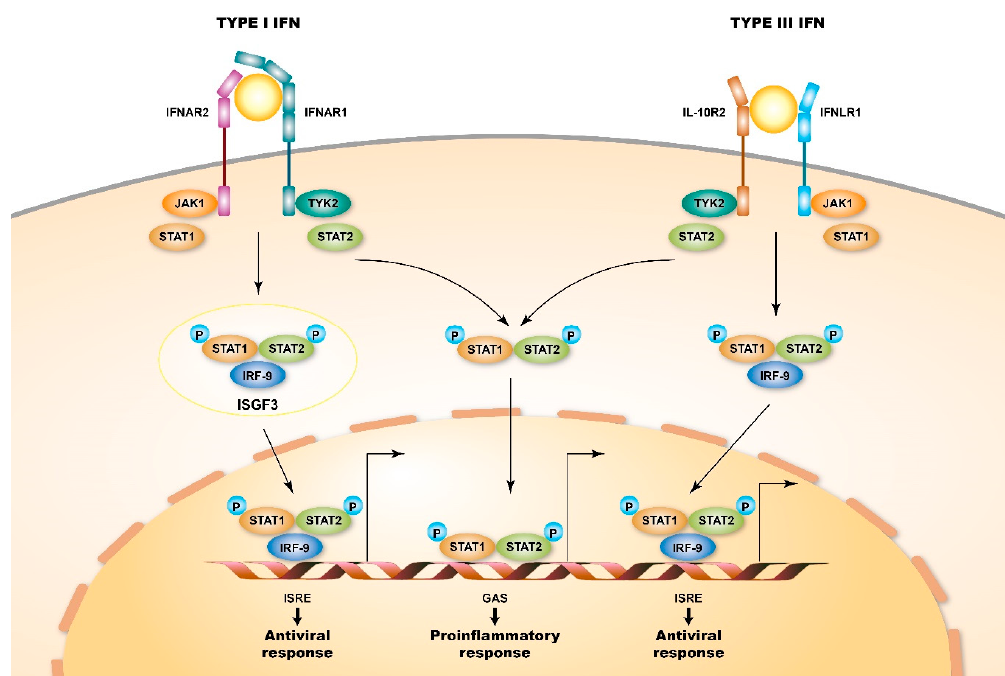
Figure 2. Signaling pathways of type I and type III IFN receptors. Type I and type III IFN receptors are heterodimers and consist of different receptor chains (IFNAR1 and IFNAR2 for the type I IFN receptor and IFNLR1 and IL10R2 for the type III IFN receptor). Both receptors are associated with two kinases from the JAK family: JAK1 and TYK2 (tyrosine kinase 2). When ligating to their cognate ligand, JAK kinases auto-phosphorylate the IFN receptor, which results in the recruitment of signal transducer and activator of transcription (STAT) proteins, phosphorylation, dimerization, and nuclear translocation. In particular, STAT1, STAT2, and IFN-regulatory factor 9 (IRF9) form interferon-stimulated gene factor 3 (ISGF3) complexes and bind to IFN-stimulated response element (ISRE) sequences, thus activating classical antiviral genes. Additionally, STAT1 homodimers bind to gamma-activated sequences (GASs), thus inducing the activation of pro-inflammatory genes.